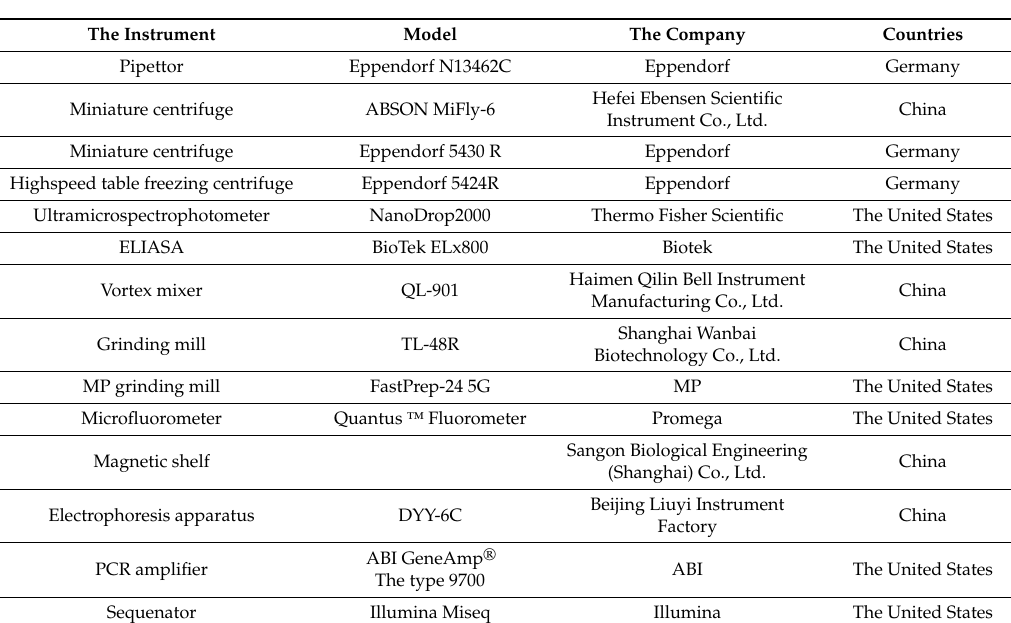
Table 5. Experimental instruments and